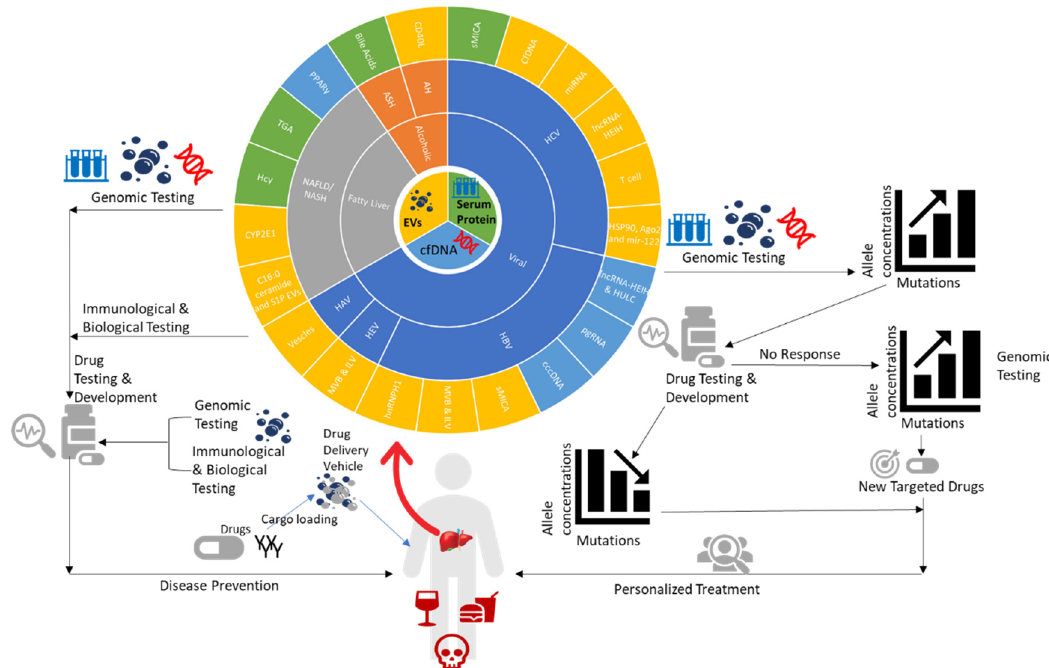
Figure 4. The potential of the liquid biopsy as a non-invasive and accurate approach to the diagnosis and monitoring of chronic liver disease by disease associated markers from EVs, cfDNA, and serum protein. Biomarks have potential for further gene allele and mutation study to design the genomic testing depends on the gene expression and sequencing result for personalized therapeutic strategy. The biomarks expression testing level not only to monitor the disease process, also can apply for the drug design, drug testing and therapeutic efficiency in the future.